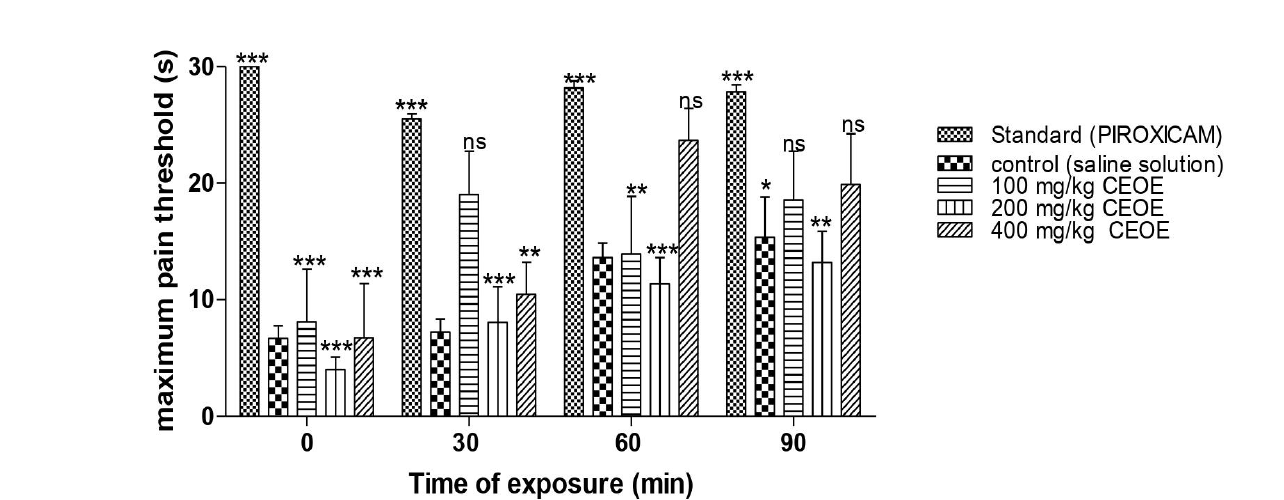
FIGURE 1 - Effect of C. equisetifolia on heat-induced nociception. Control, Standard and CEOE represent 1 mL saline solution, 100 mg/kg of piroxicam and 100, 200 and 400mg/kg of essential oil of C. equisetifolia respectively. *** p < 0.01 statistically compared to